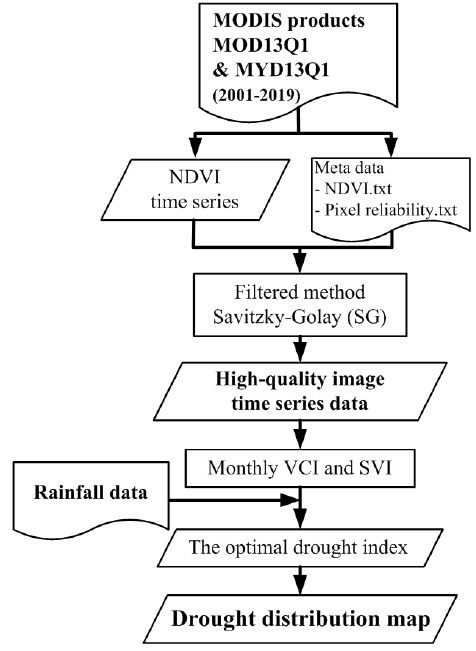
Figure 1. Illustration of the implemented workflow diagram for drought monitoring from 2001 to 2019 in Northeast Thailand.